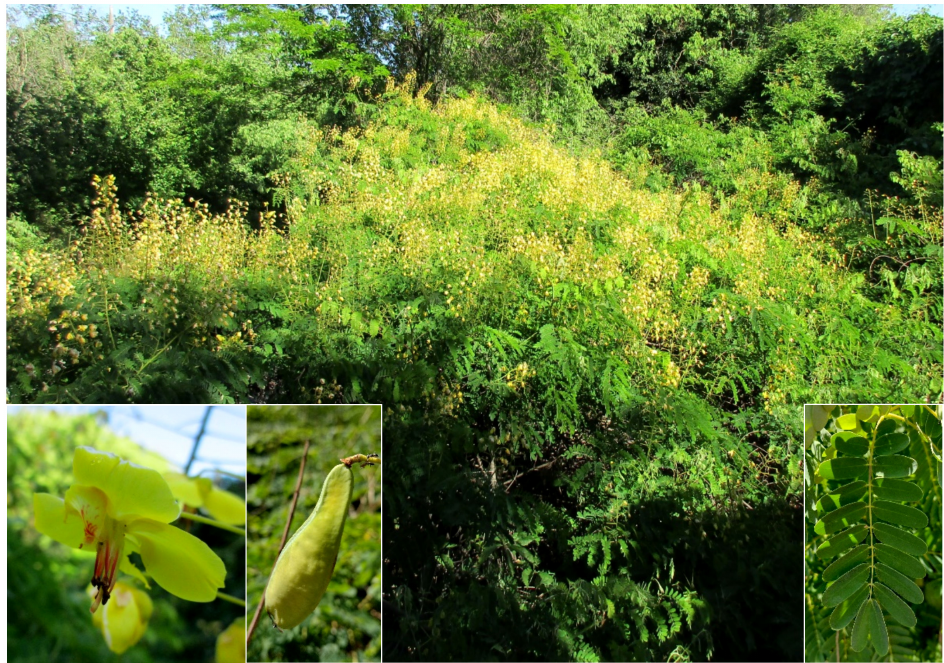
Figure 43. Denisophytum bessac on the western side of Caffarella valley; flower and fruit (bottom-left insets), pinna (bottom-right